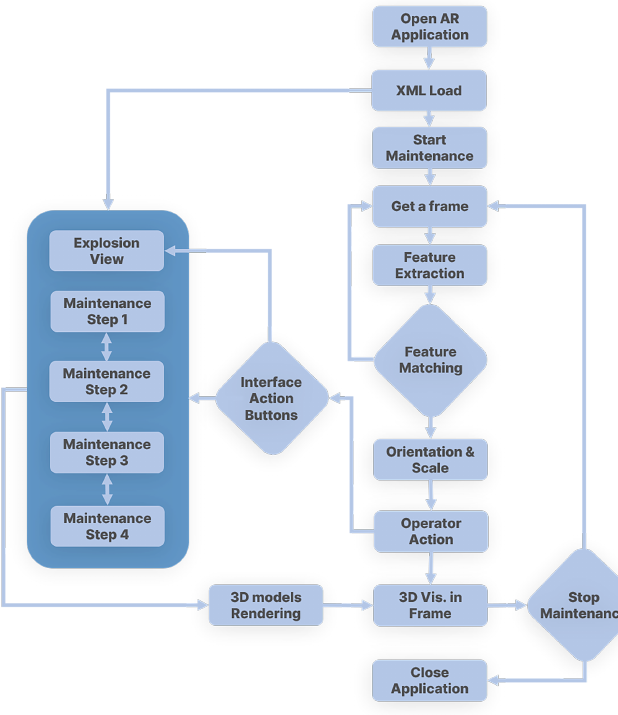
Figure 2. Flowchart of the proposed augmented reality method for fast track maintenance